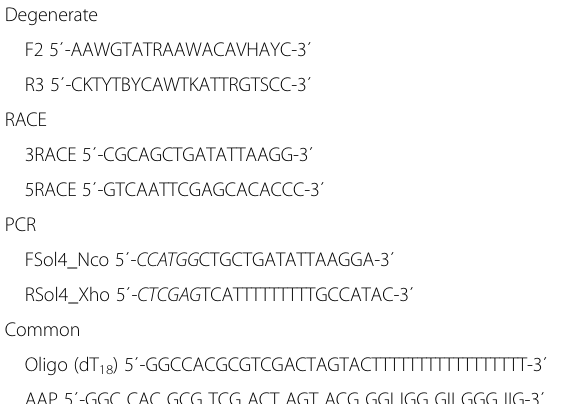
Table 1 List of primers used in PCR and